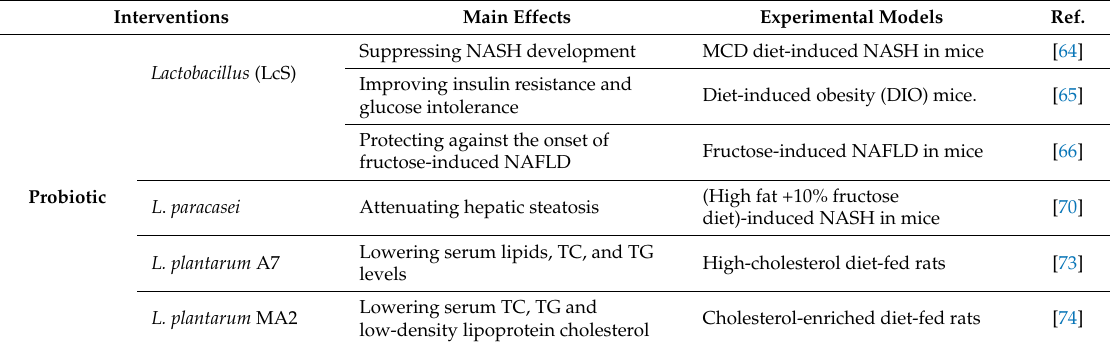
Table 1. Gut microbiota-targeted therapies of NAFLD with